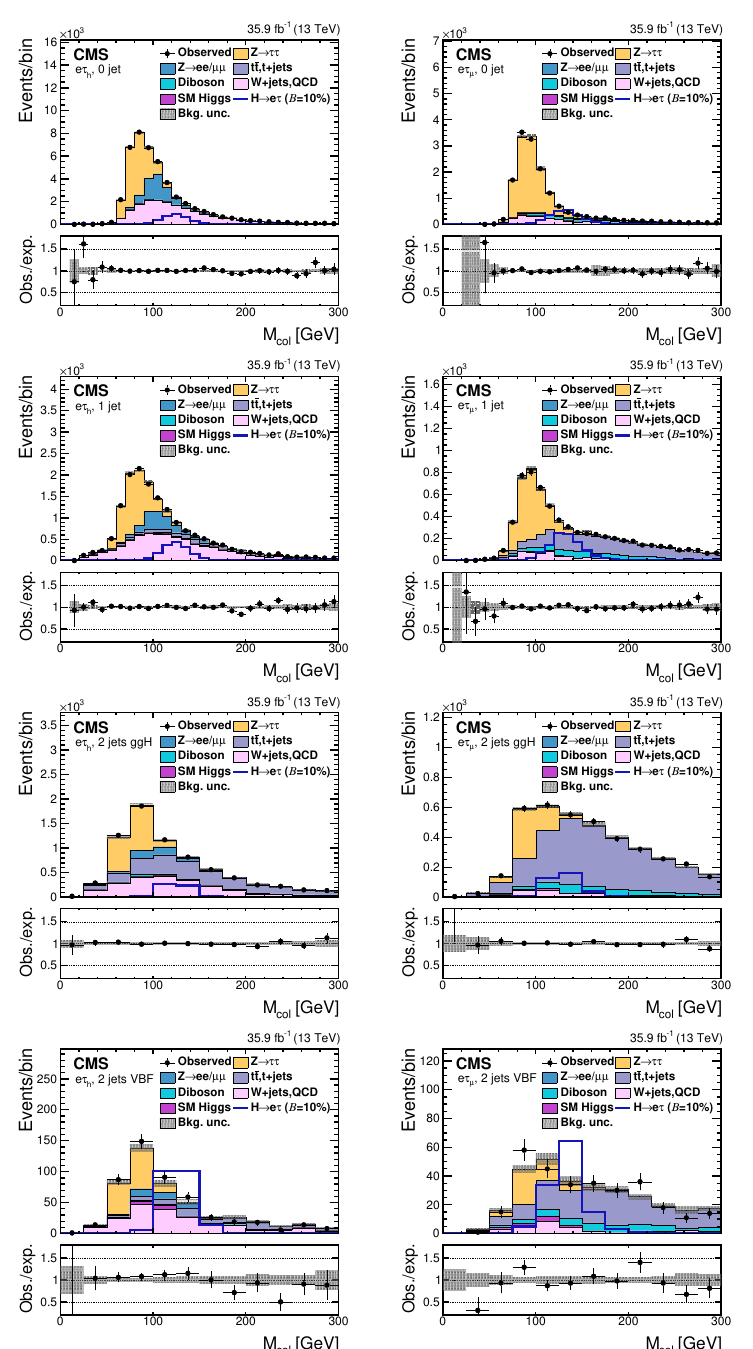
Figure 8 . Distribution of the collinear mass M col for the H ! e (cid:28) process in the M col (cid:12)t analysis, in di(cid:11)erent channels and categories compared to the signal and background estimation. The back- ground is normalized to the best (cid:12)t values from the signal plus background (cid:12)t while the simulated signal corresponds to B (H ! e (cid:28) ) = 5%. The lower panel in each plot shows the ratio between the observed data and the (cid:12)tted background. The left column of plots correspond to the H ! e (cid:28) h categories, from 0-jets ((cid:12)rst row) to 2 jets VBF (fourth row). The right one to their H ! e (cid:28) (cid:22) counterparts.